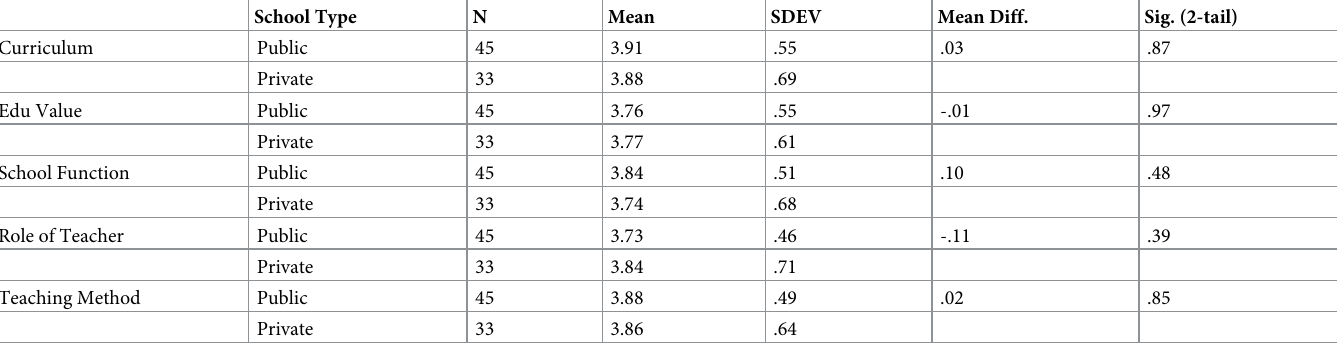
Table 10. Comparison of private and public school teachers with respect to the five categories.